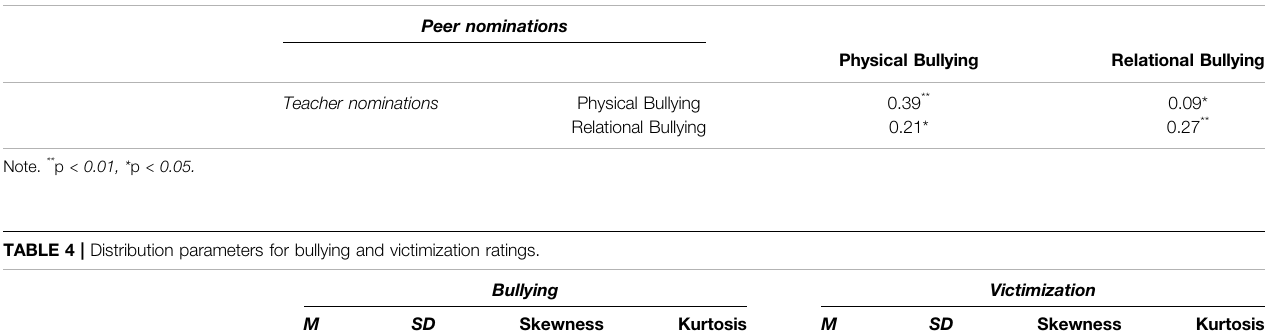
TABLE 3 | Correlations between teacher and peer nominations.